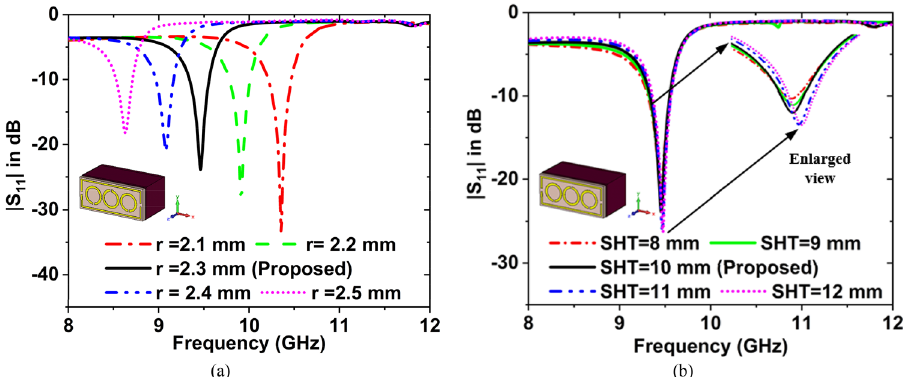
Figure 9. Effect on the resonance frequency for the change of ( a ) circle radius, and ( b ) sample holder thickness.